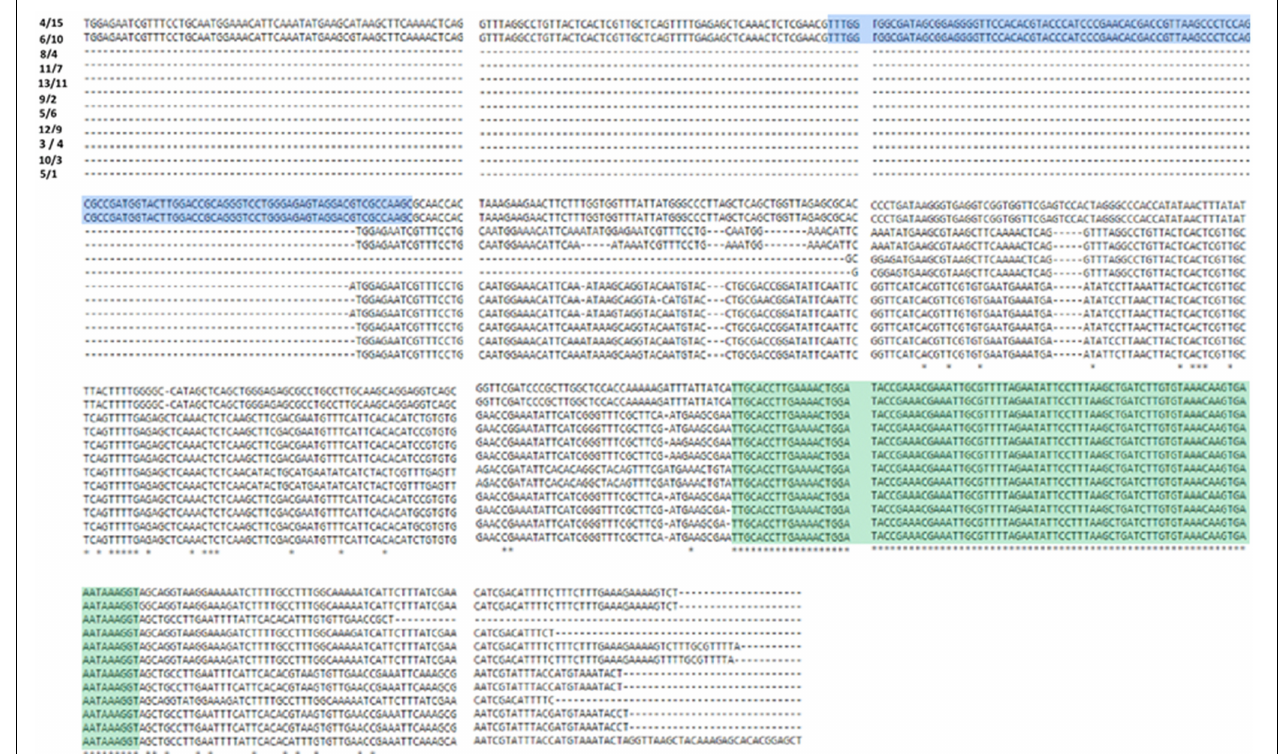
FIGURE 8 | Clustal (cid:2) alignment of the 16S and 23S ribosomal subunit intragenic region of the CR1 genome. Numbers to the left of sequence data represent the specific contig gap where the ribosomal subunit DNA was located. CR1 encoded ribosomal subunit DNA was unanimously localized to gaps from the draft genome. Intragenic DNA